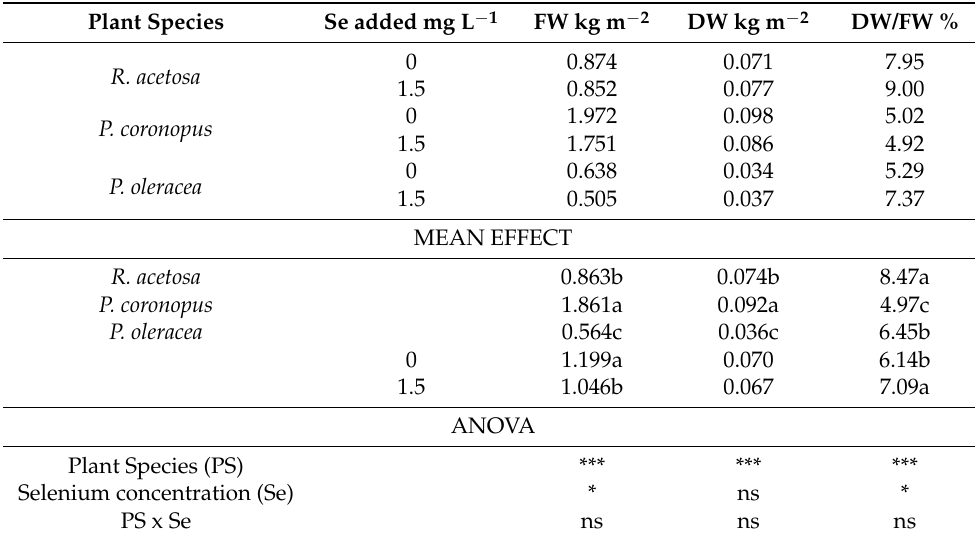
Means (n = 3) flanked by the same letter are not statistically different for p = 0.05 after Duncan’s test. Significance level: *** p ≤ 0.001; * p ≤ 0.05; ns = not